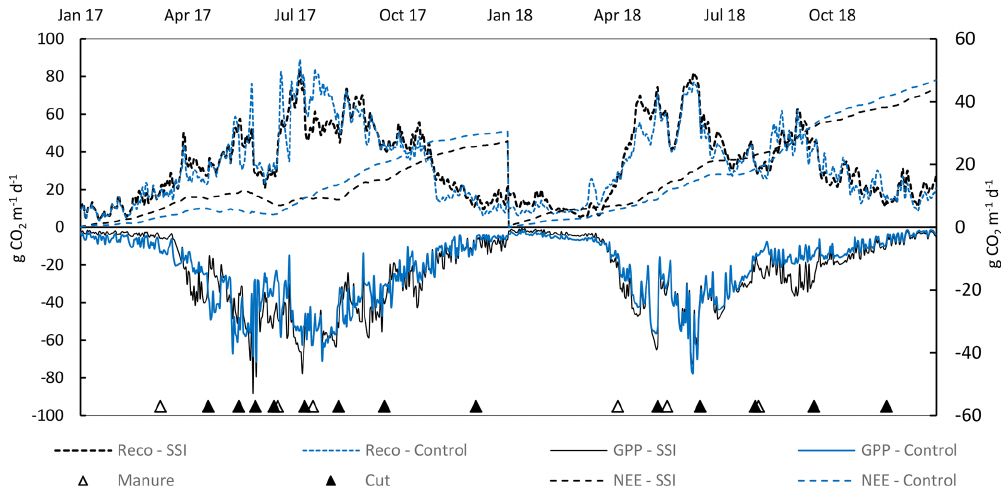
Figure 7. R eco and GPP for location B in gCO 2 m − 2 d − 1 on the primary y axis, for control and SSI. Accumulative NEE in tCO 2 ha − 1 yr − 1 , for control and subsoil irrigation (SSI), every year starting at